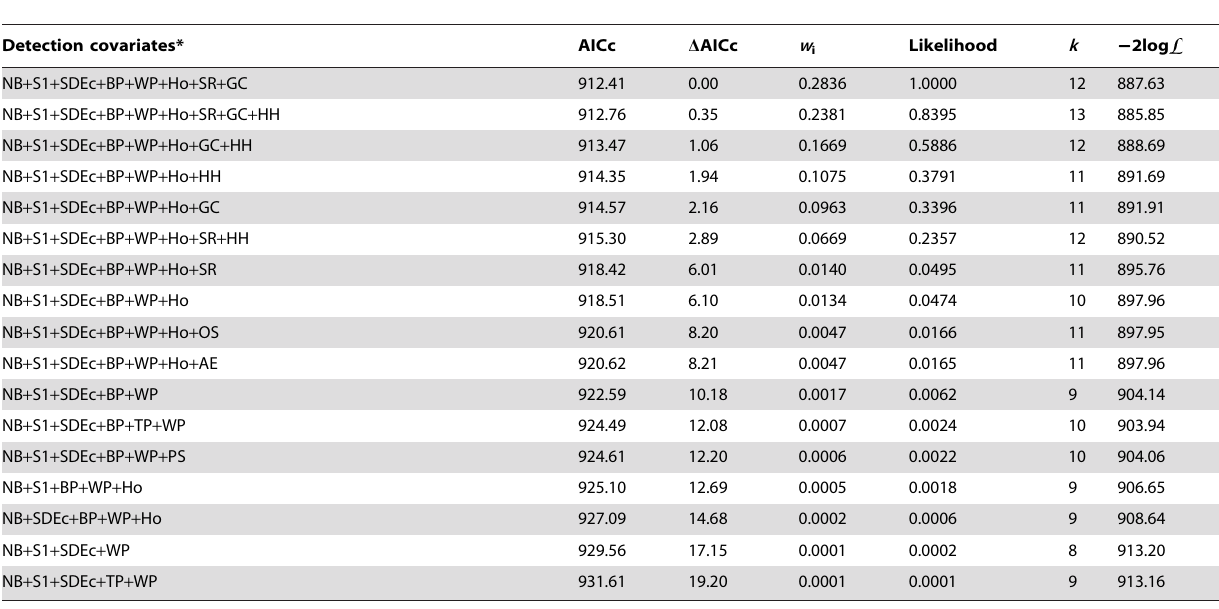
Table 4. The subset of multiple detection-state models with non-zero Akaike weights; models are ranked by their AICc scores.